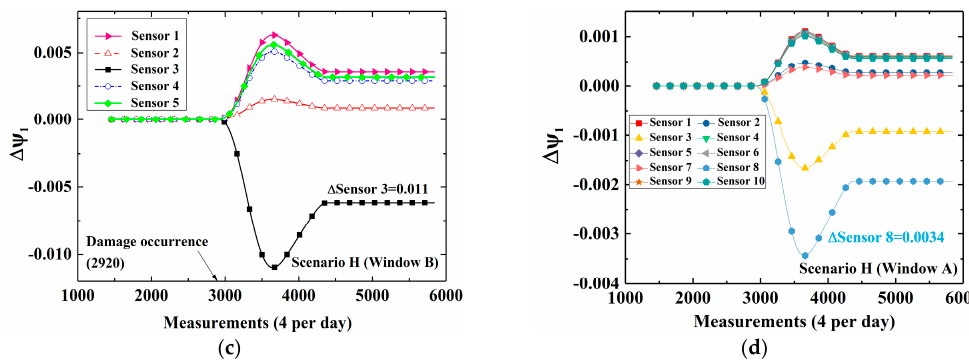
Figure 11. Time-variant CEVs with different space windows for Scenario H: ( a ) Window D; ( b ) Window C; ( c ) Window B; ( d ) Window A.